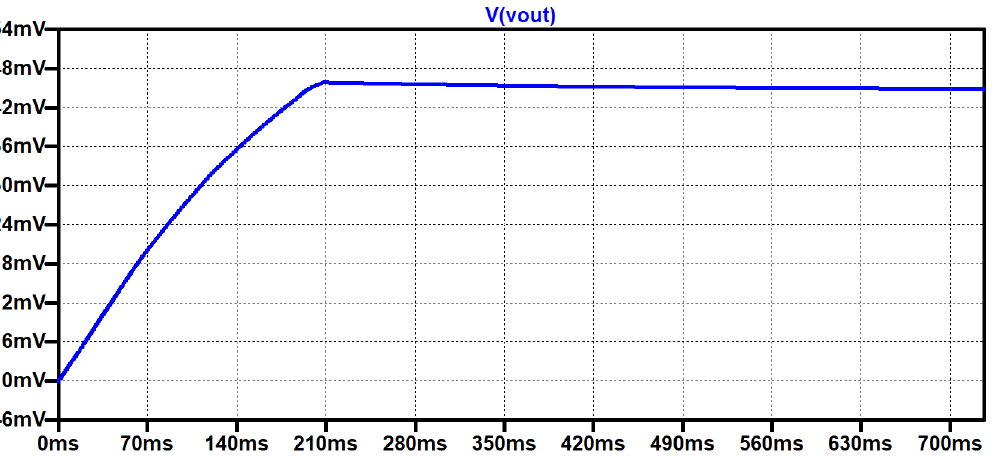
Figure 6. The output voltage response of Si-MOSFET-based switch for an open-circuit configuration.